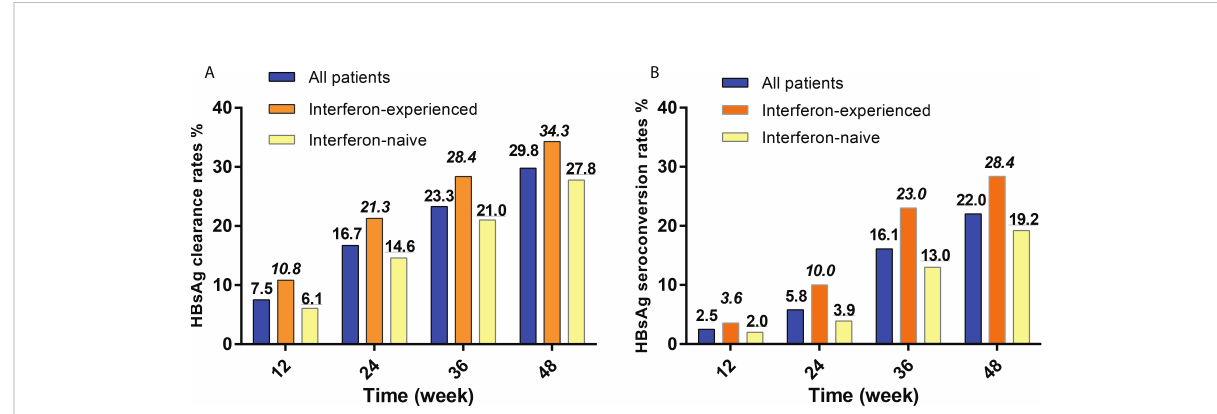
FIGURE 2 HBsAg clearance and seroconversion rates of interferon-experienced and interferon-naive patients. (A) HBsAg clearance rates of interferon- experienced and interferon-naive patients. (B) HBsAg seroconversion rates of interferon-experienced and interferon-naive patients. HBsAg, hepatitis B surface antigen. Interferon-naive patients meant patients who never used interferon but used nucleos(t)ide analogs therapies for more than 1 year and then met the inclusion criteria of this study; Interferon-experienced patients meant patients who used peg-interferon therapies for more than 24 weeks, did not achieve clinical cure or HBV-DNA clearance, and switched to nucleos(t)ide analogs for more than 1 year, and then met the inclusion criteria of this study.